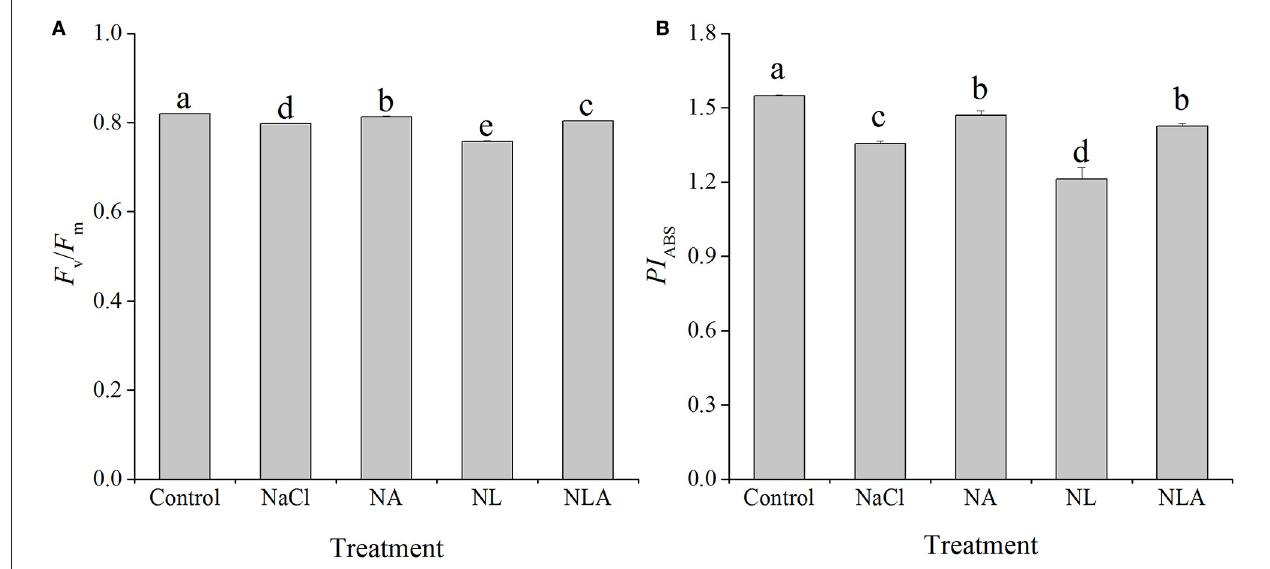
FIGURE 11 | Values of the maximal photochemical efficiency of PSII ( F v / F m ) (A) and performance index on absorption basis ( PI ABS) (B) in the leaves of salt-stressed tomato seedlings with or without exogenous ascorbic acid (AsA) and lycorine (LYC) spraying. Values are means ± SD ( n = 3). Different letters (a, b, c, d, and e) indicate significant difference at P < 0.05 among treatments. Error bar is smaller than the line at the top of the graph. Control, no added NaCl, no sprayed AsA and LYC; NaCl, added 100 mmol/L NaCl; NA, added 100 mmol/L NaCl and sprayed 0.5 mmol/L AsA; NL, added 100 mmol/L NaCl and sprayed 0.25 mmol/L LYC; NLA, added 100 mmol/L NaCl and sprayed 0.25 mmol/L LYC and 0.5 mmol/L